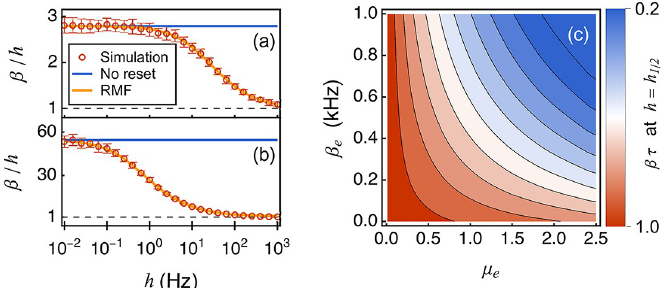
Fig 5. Nonlinearity of firing rates with post-spiking reset mechanism. In panel (a) and (b), the log-linear plots of β / h v.s. h show the nonlinearity resulted from the post-spiking reset mechanism. In panel (a), the neuron is subjected to a single excitatory input with β e = 1 kHz and μ e = 1, while in panel (b), the input is of β e = 1.5 kHz and μ e = 2.5. Panel (c) is the contour plot of the value of β τ at mid-point h 1/2 , where excitatory input rate β and strength μ are varied. The e e contours are equidistant with respect to the value of β τ . For the simulated data, we run the event-driven simulation until 400 spiking events for the single neuron are accumulated. This process is repeated 32 times. During each repetition, we record the total time T ( k = 1, ��� , 32). The mean firing rates of the neuron are then computed by k � b ¼ ð P 32 400 = T Þ = 32 . The standard deviations of the rates (indicated by error bars) over these 32 repetitions are k P k ¼ 1 32 computed by taking the square root of ð ð S ¼ 400 = T Þ 2 (cid:0) � b 2 Þ = ð 32 (cid:0) 1 Þ . Parameters: a = 0.1, τ = 10 k k ¼ 1